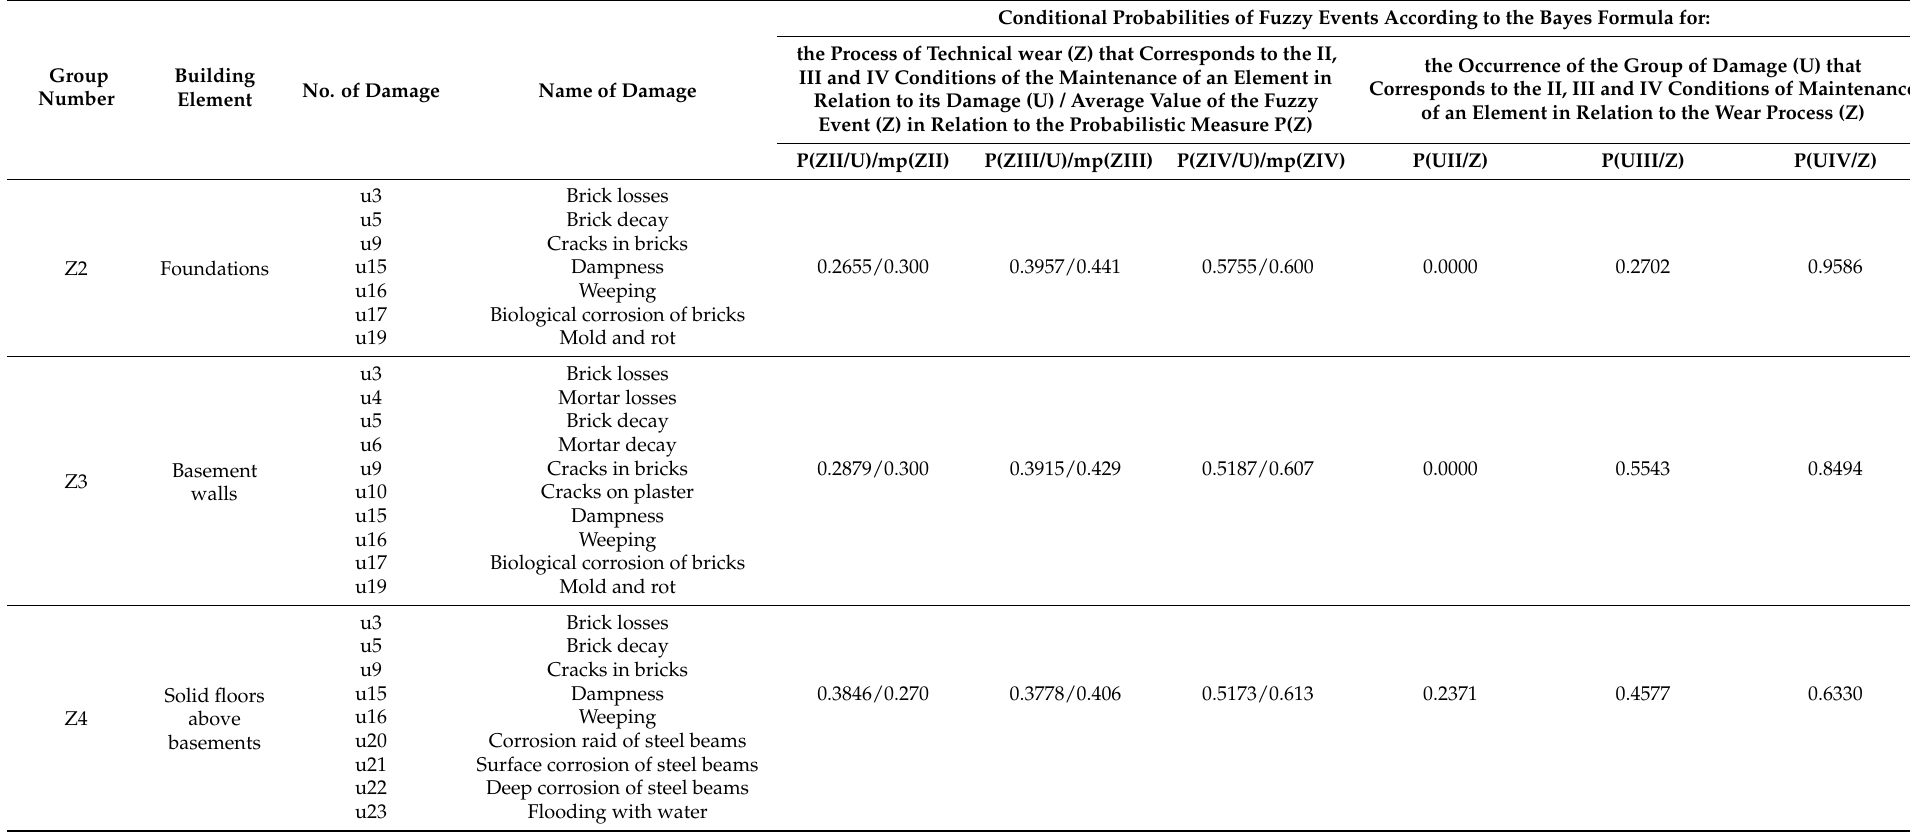
Table 2. Fuzzy conditional probabilities of the technical wear process in relation to the probabilistic measure and the occurrence of damage, as well as the fuzzy conditional probabilities of the occurrence of a group of damage in relation to the technical wear